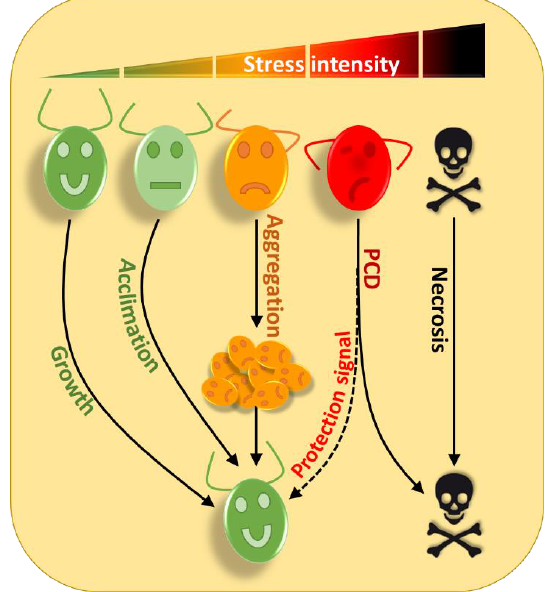
Figure 1. The strategies used by Chlamydomonas to survive increasing stress intensities. Under optimal conditions Chlamydomonas can grow normally (green cell); under moderate stress conditions (light green cell), several acclimation processes can be triggered to allow the cells to better adapt and resist the occurrence of any additional stress of similar or greater magnitude. Under more intense stress conditions (orange cell), cells can form multicellular structures such as palmelloids or aggregates that can dissociate when environmental conditions improve. Under very harsh stress conditions (red cell),